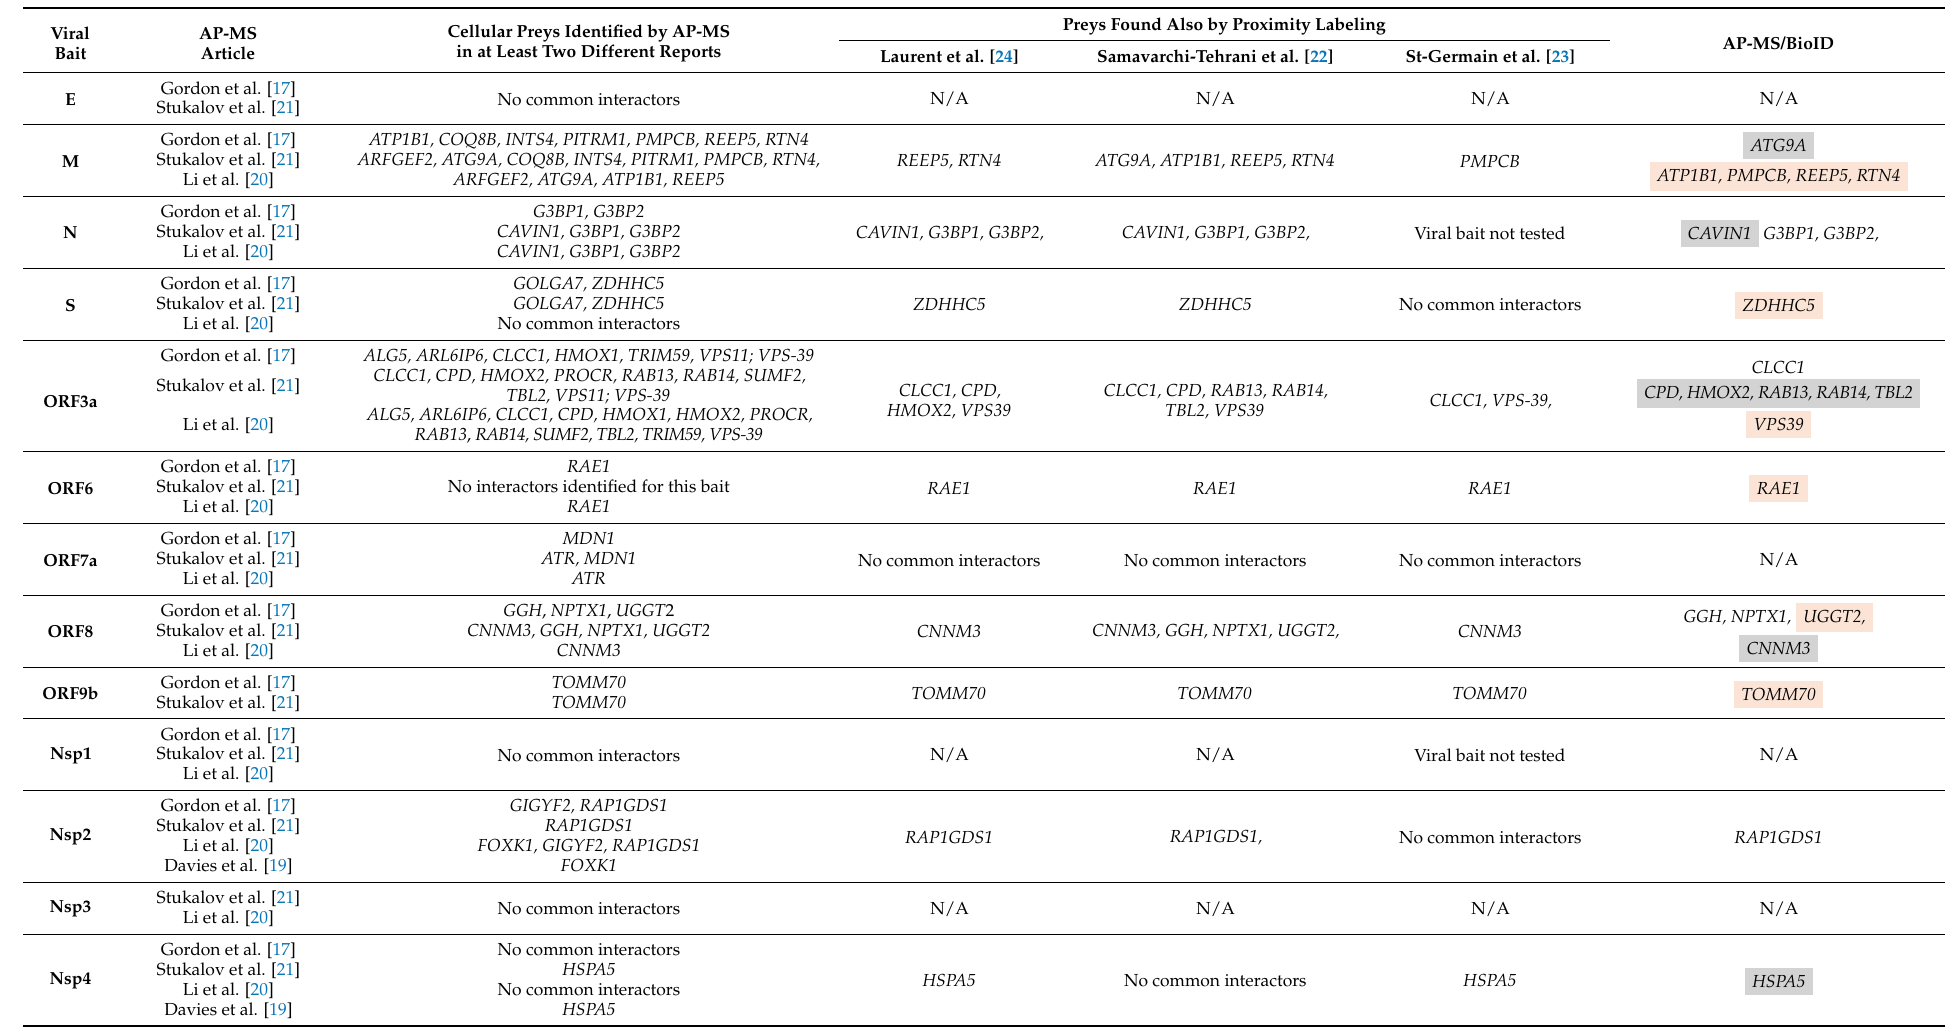
Table 3. Relevant common